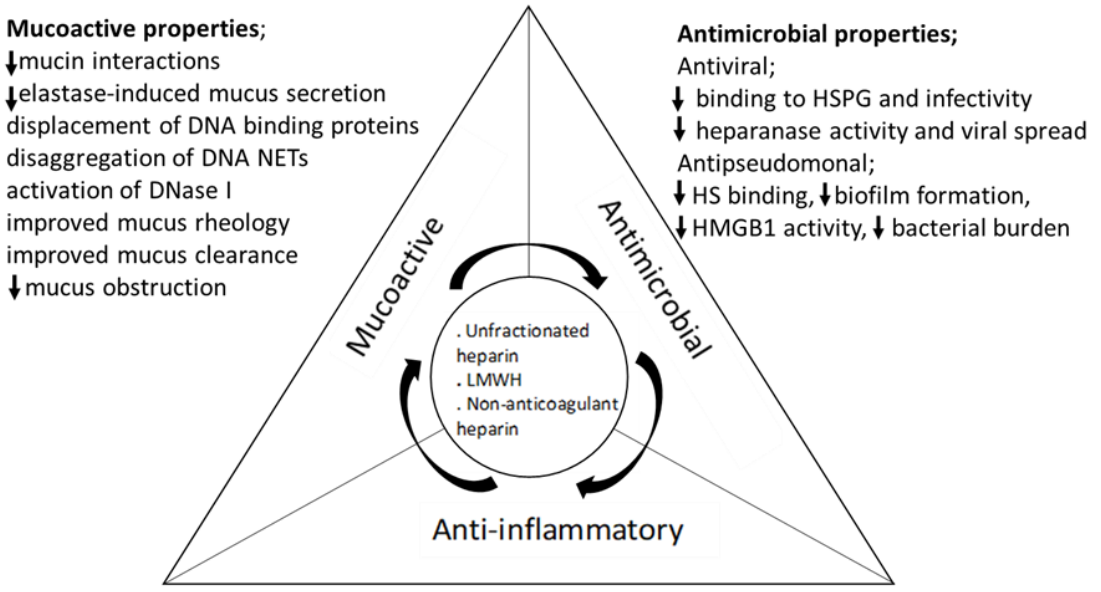
Figure 2. The anti-inflammatory, anti-microbial, and mucoactive pharmacological properties of heparin and its derivatives are proposed to reduce mucus obstruction of the inflamed airways, and the cycles of infection and inflammation that lead to tissue damage. NETs; neutrophil extracellular traps. HSPG; heparan sulphate proteoglycan. HS; heparan sulphate. HMGB1; high mobility group box 1. Downward arrows indicate a decrease in the described